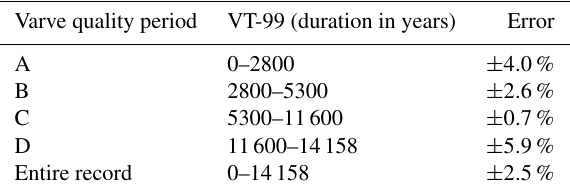
Table A2. Error (1 σ ) estimations for different varve quality periods for the Holzmaar record (Zolitschka, 1998b), updated from VT-95 to